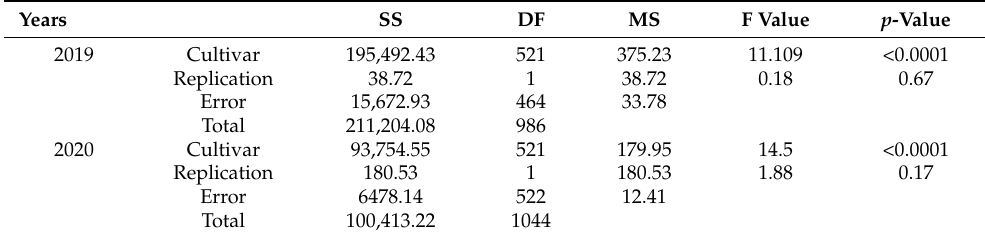
Table 1 . ANOVA for wheat reactions to CR in 2019 – 2021.